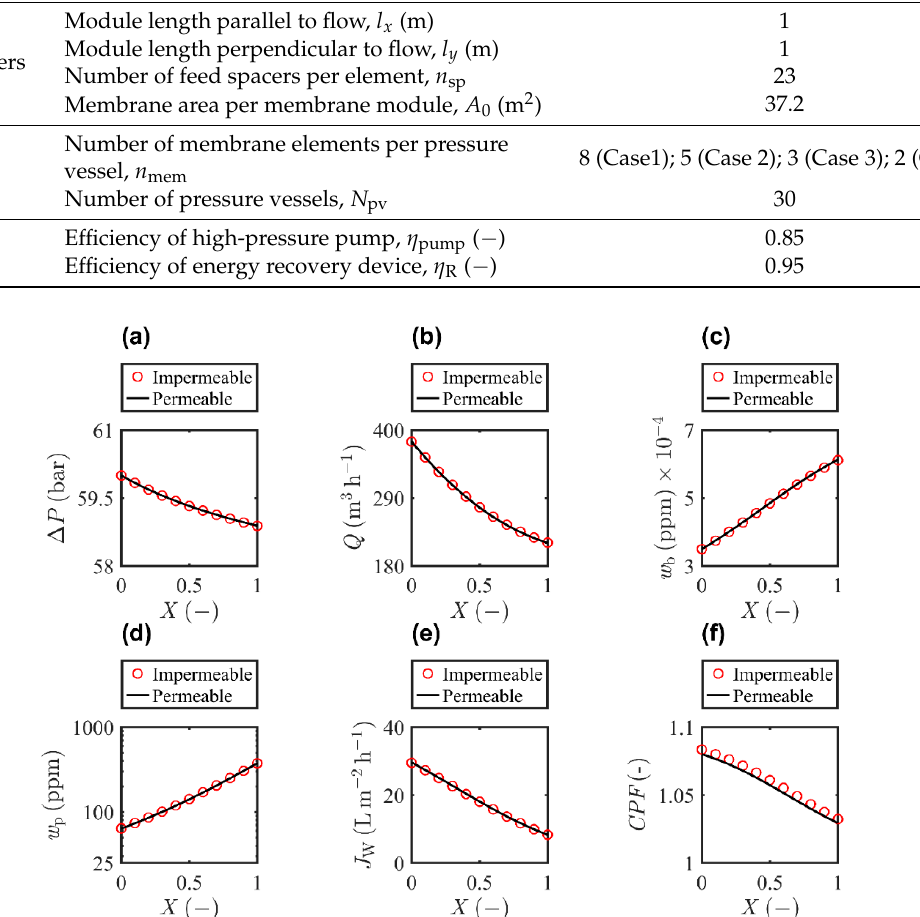
Figure 8. The simulated results at the system level using the impermeable and permeable wall models with the feed salinity ( w b, 0 = 35,000 ppm), water recovery ( R r, 0 = 50%), pump efficiency (0.85), energy recovery device efficiency (0.95) and water permeability ( L p = 1 L m − 2 h − 1 bar − 1 ). ( a ) Transmembrane pressure, ∆ P (bar), ( b ) Flow rate, Q (m 3 h − 1 ), ( c ) Brine salinity, w b (ppm), ( d ) Permeate salinity, w p (ppm), ( e ) Permeation flux of water, J W (L m − 2 h − 1 ), ( f ) CP factor, CPF ( − ) along the dimensionless length ( X ).